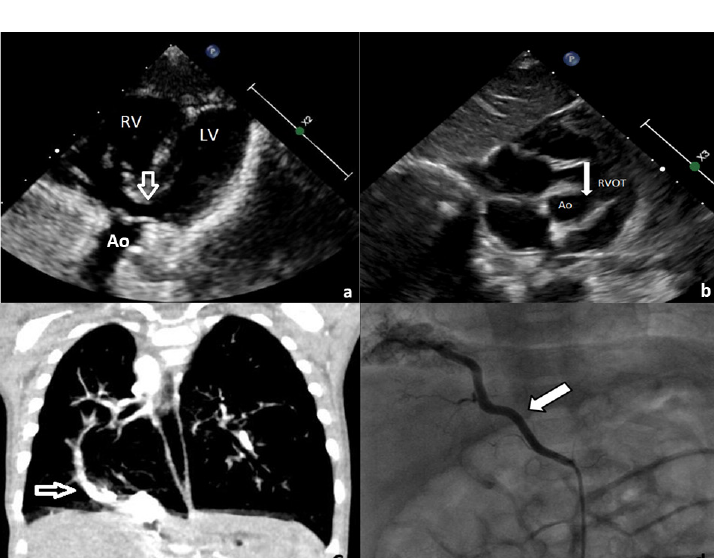
Fig. 1 – Echocardiographic 2D-modified subcostal